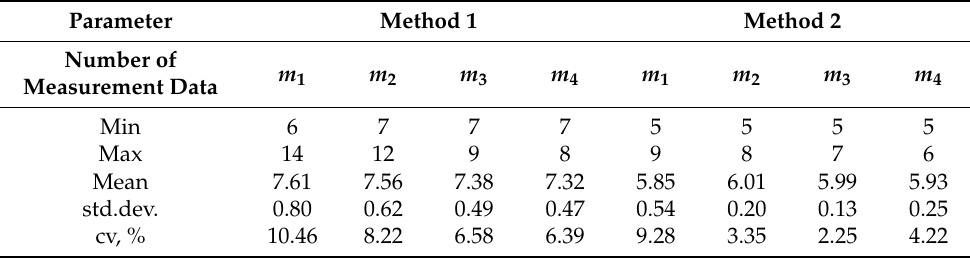
Figure 12. Ratio Je/Jm in the state-estimation process for load level V 1.5 . Table 1. Number of iterations in the state estimation for load level V 0.5 .